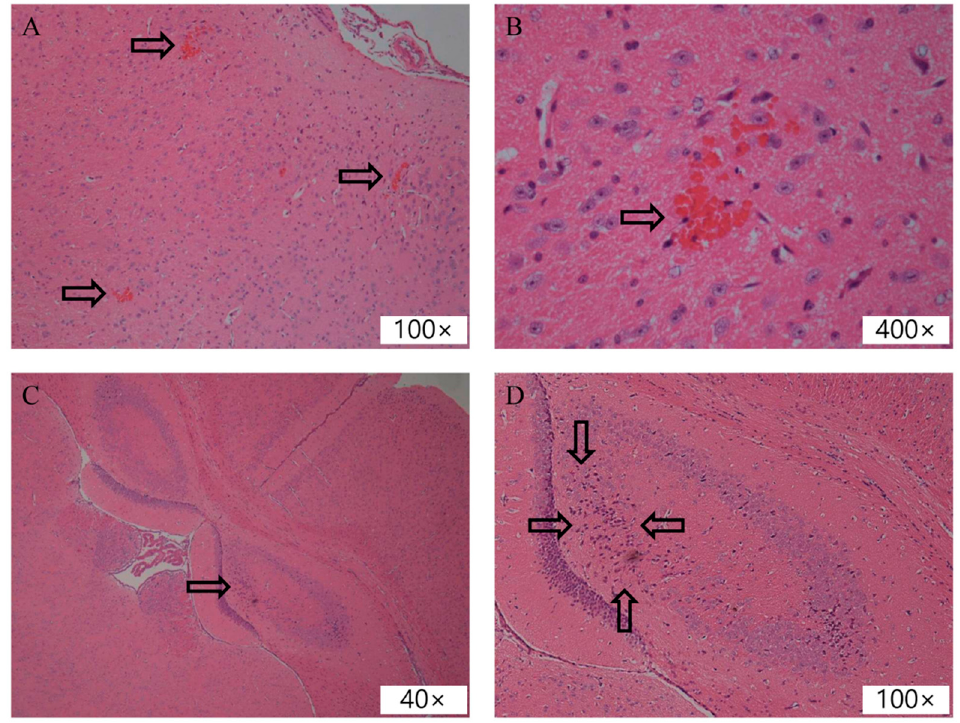
Figure 7. Tissue sections of brain parenchyma with hematoxylin and eosin stain. ( A ) Grade 2 lesion; the arrows indicate scattered microhemorrhages. This mouse was treated with one-spot sonication. ( B ) Magnified view of the hemorrhage in Panel ( A ); ( C ) Grade 2 lesion; the arrow indicates degenerated neurons. This mouse was treated with two-spot sonication. ( D ) Magnified view of Panel ( C ).